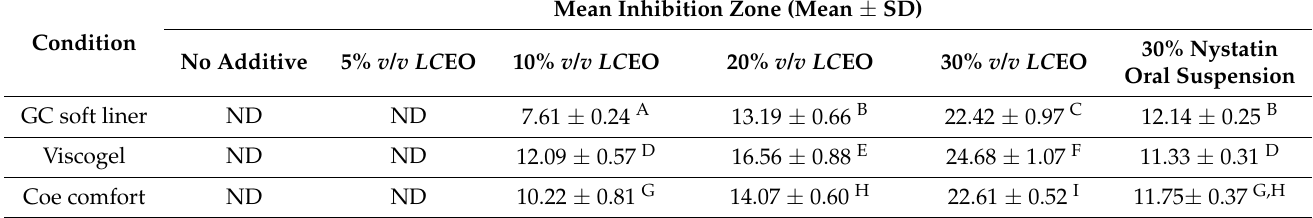
Table 5. Mean inhibition zone ± SD ( n = 5) of various additives incorporated into three soft lining materials (GC soft liner, Viscogel and Coe comfort) against S. mutans. Inhibition zone less than 6.0 mm was defined as not detected (ND). Statistical difference in various concentrations of LC EO and chlorhexidine mouthwash is compared in the same row and the same capital letter s indicate no significant difference in inhibition zone diameter ( p > 0.05). No comparison among the three soft lining materials was